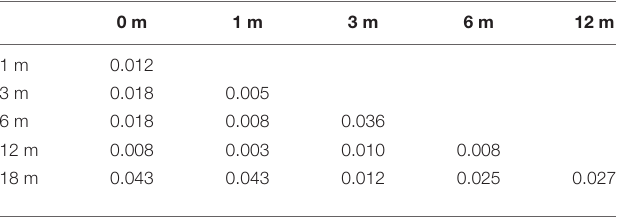
TABLE 2 | Comparison of the percentage of Meaningful Auditory Integration Scale/Infant-Toddler Meaningful Auditory Integration Scale (MAIS/IT-MAIS) scores for each time point in the common cavity deformity (CCD) group.